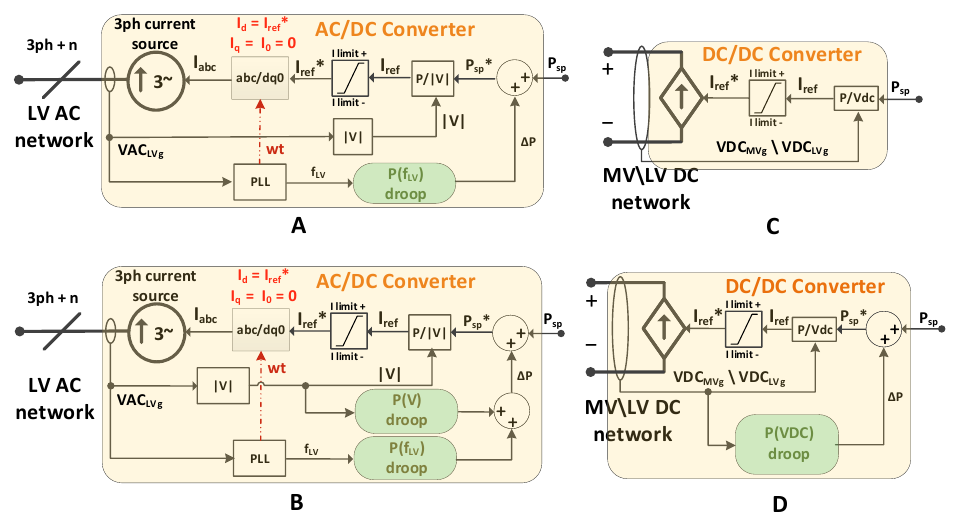
Figure 12. Block diagram of the developed computational models for the controllable DER units: AC ( A ) and DC ( D ) PV generation, ESS ( B ), and EV chargers ( C